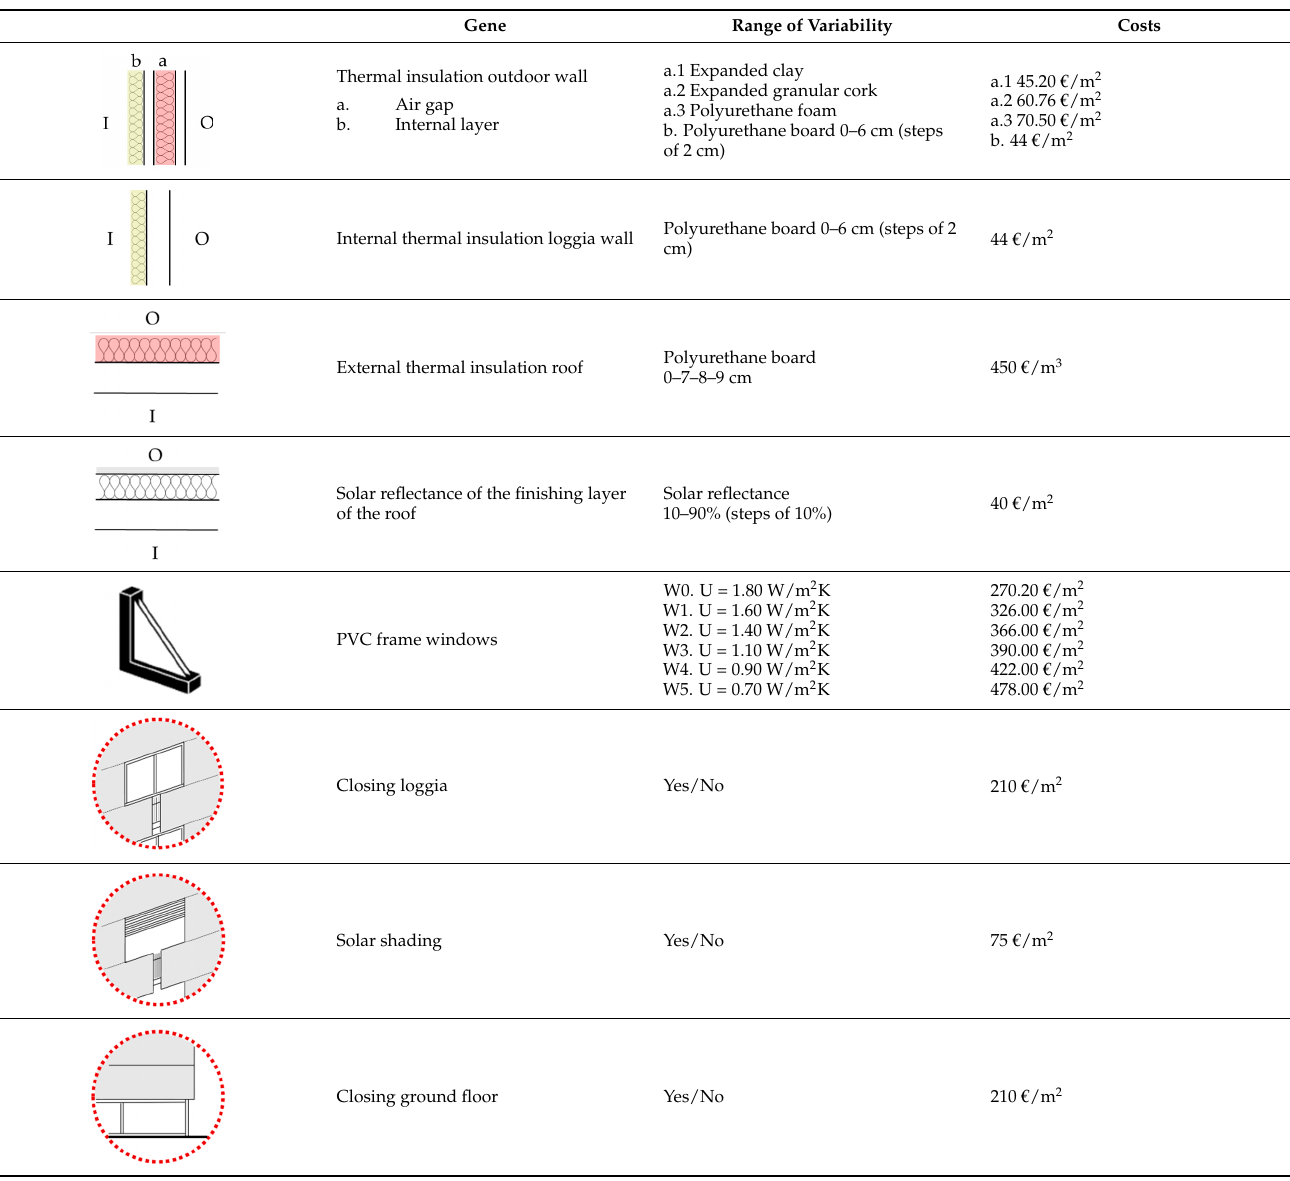
Table 2. Investigated genes for the energy retrofit, range of variability, and costs.